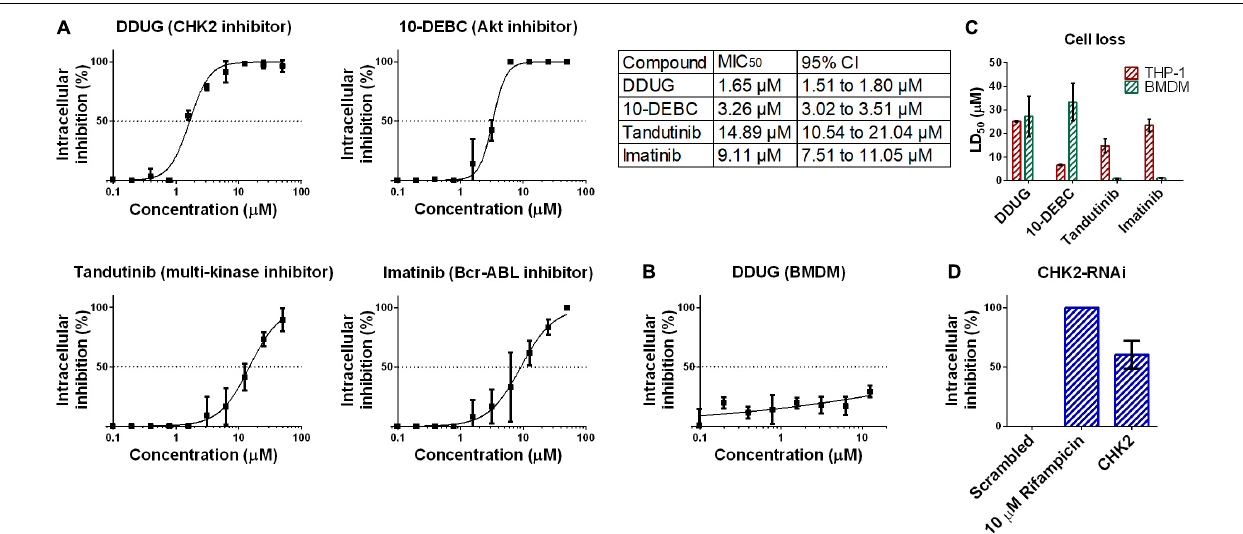
FIGURE 3 | Confirmation of DDUG inhibition of M.tb growth in infected THP-1 cells. Dose-dependent inhibition of M.tb :THP-1 intracellular growth by novel and established compounds, normalized to 1% DMSO negative control (0% inhibition) (A) . CI, confidence interval. DDUG inhibition of M.tb growth in infected bone marrow derived macrophages (BMDM) cells (B) . Dose-dependant cell loss of THP-1 (red) and bone marrow derived macrophages (BMDM) cells (green) (C) . M.tb intracellular growth inhibition by RNAi suppression of the DDUG target, CHK2, interpolated to the negative control (1% DMSO) set at 0% inhibition and the positive control (4 µ M bedaquiline) defined as 100% inhibition (D) . Each data point is an average of 4 independent trials, and error bars are the SEM.